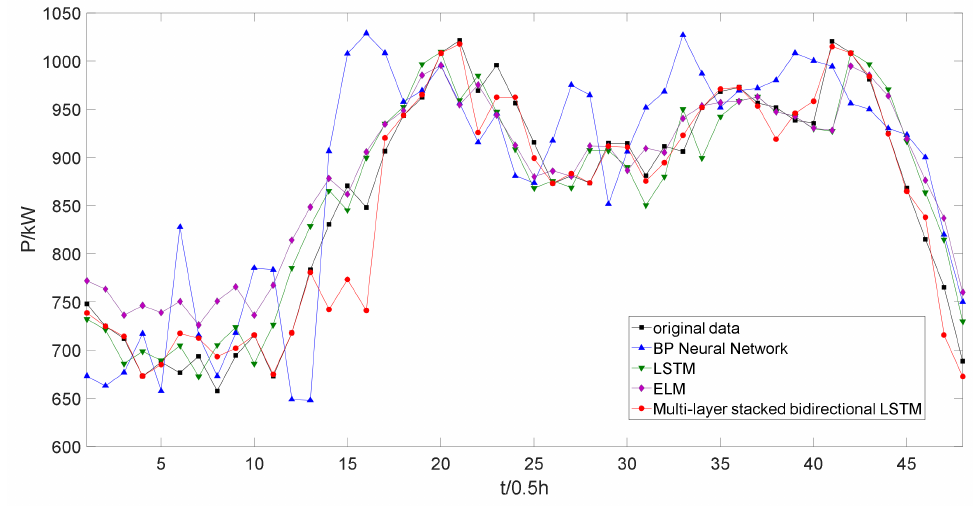
Figure 10. The load forecasting for a weekend with a 0.5 h sample training